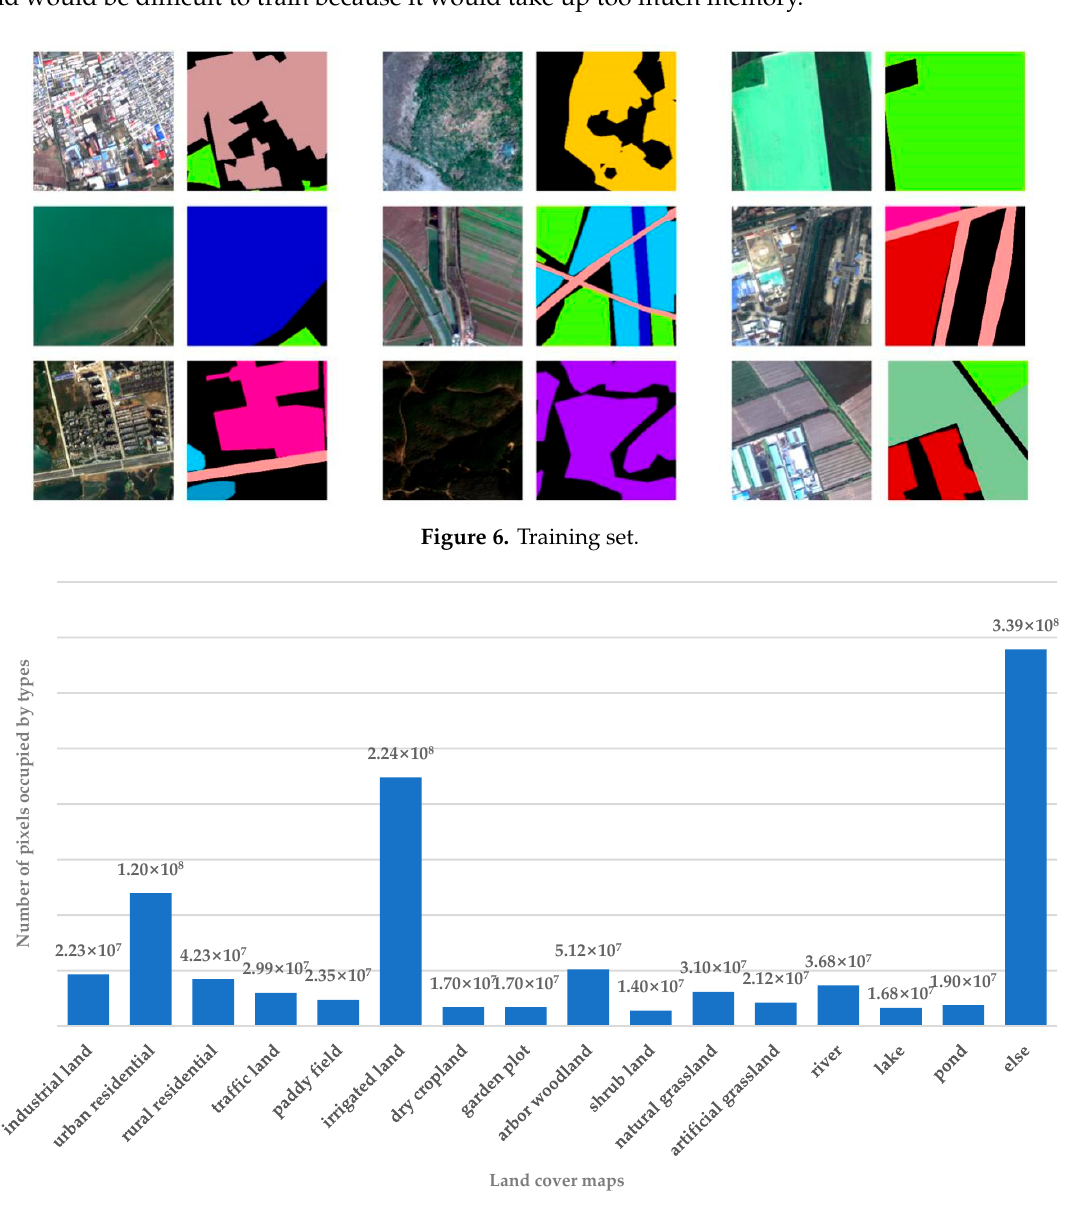
Figure 7. Training set